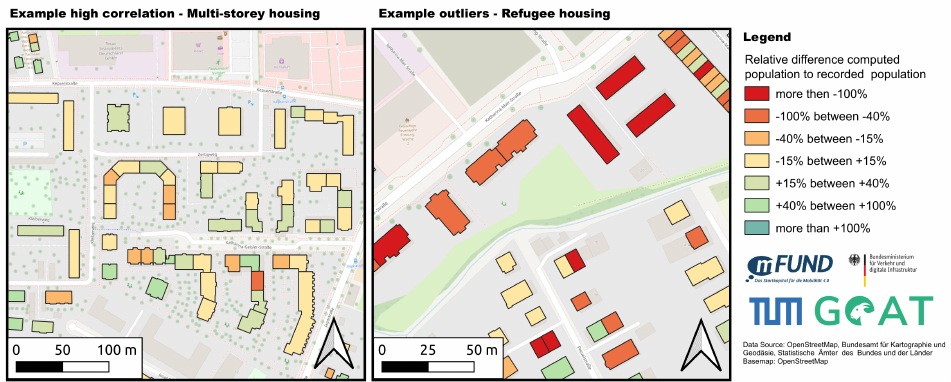
Figure 15. Comparison disaggregated and recorded population data on the building level.